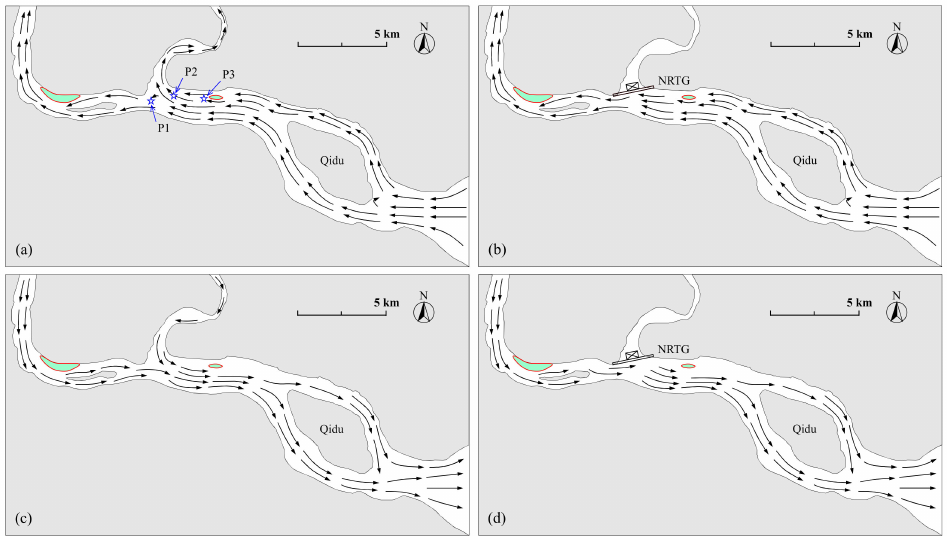
Figure 6. Model characterization of the flow stream lines via photographic sequence: peak floods ( a ) without and ( b ) with NRTG, and peak ebb ( c ) without and ( d ) with NRTG. The red line encloses the intertidal zone with plants. Blue stars mark the positions of observation points (P1, P2, and